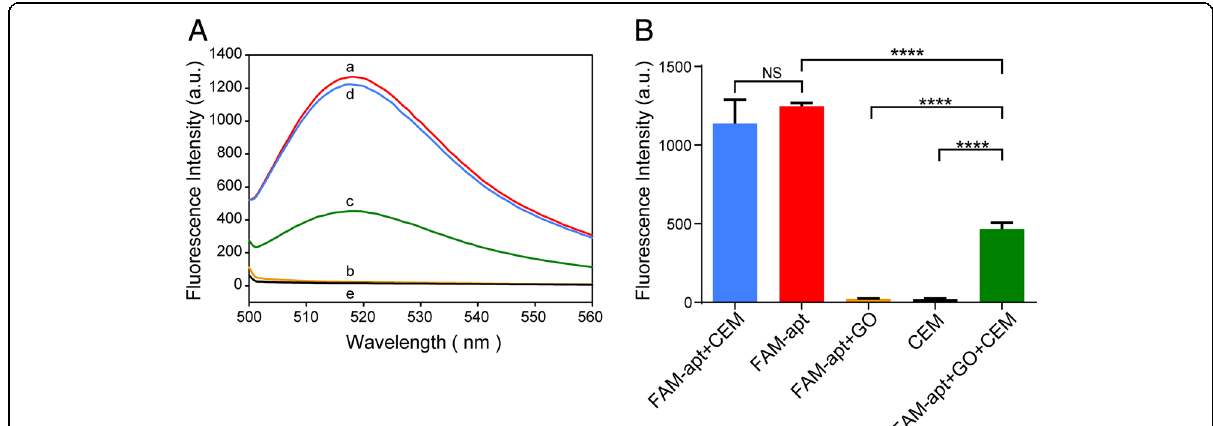
Fig. 2 Feasibility of Go-apt detection of CEM Cells. a Fluorescence emission spectra of FAM-apt and CCRF-CEM cells at different conditions: (a) FAM-apt, (b) FAM-apt + GO, (c) FAM-apt + GO + CCFF-CEM, (d) FAM-apt + CCFF-CEM, and (e) CCRF-CEM; FAM-apt (20 nM); GO (25 μ g/mL); CCRF- CEM (1 × 10 6 cells). Excitation 490 nm. b Statistical analysis of fluorescence emission spectra of FAM-apt and CCRF-CEM at different conditions. NS not significant. **** P <